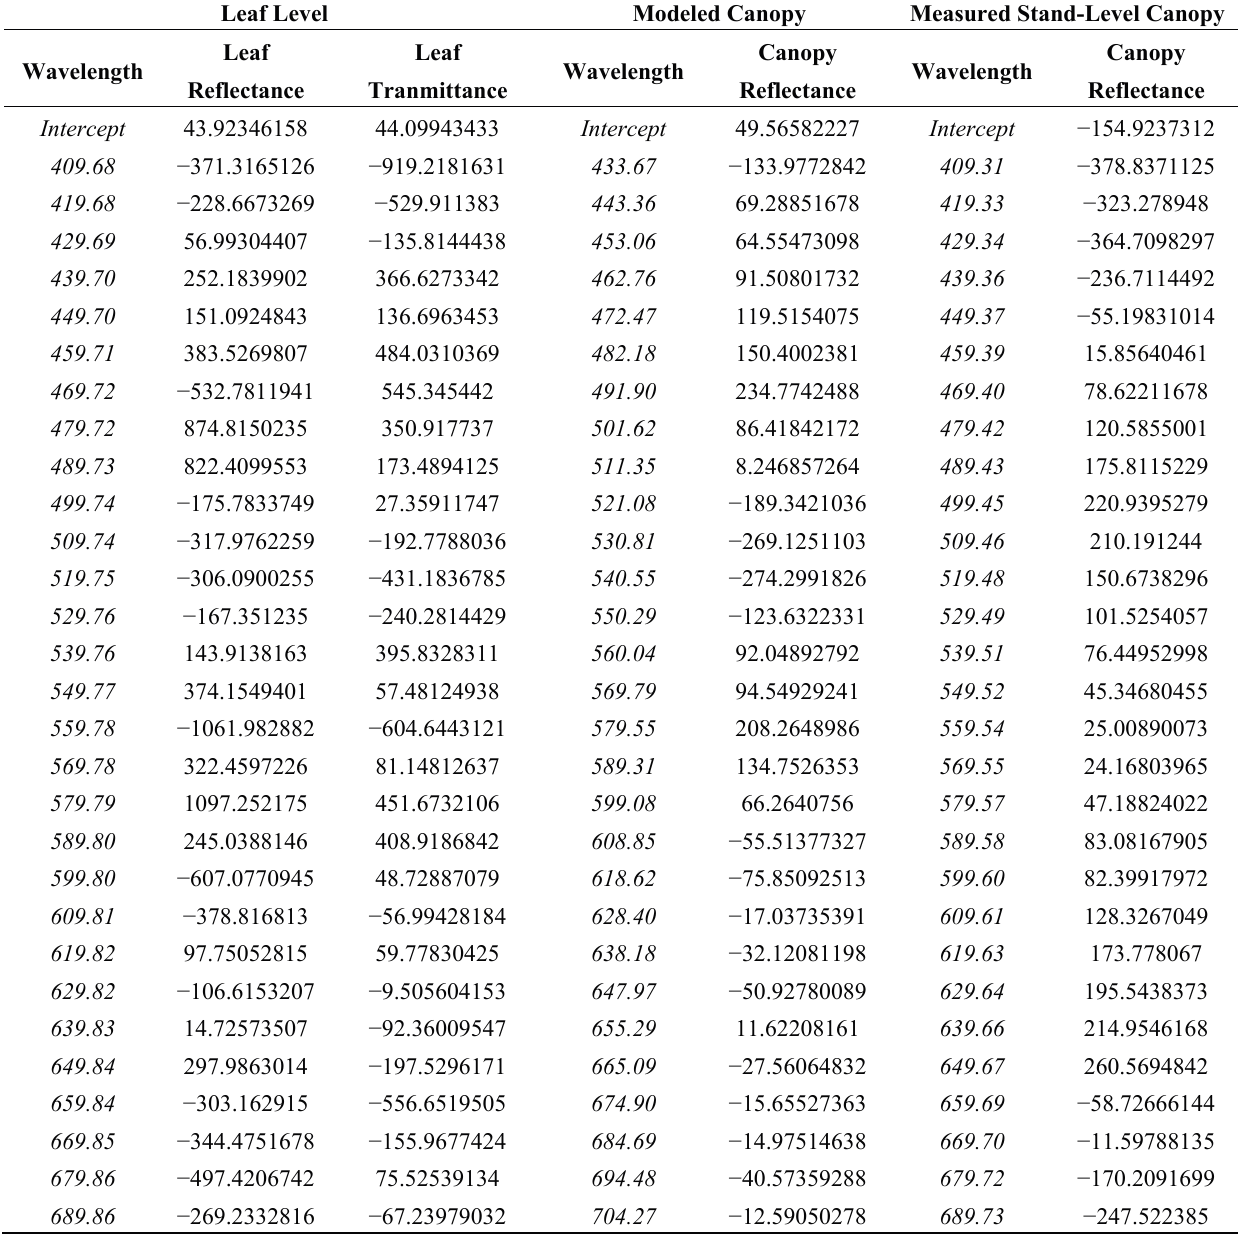
Table A1. PLSR Weightings for Non-structural Carbohydrates (NSC) in Forest